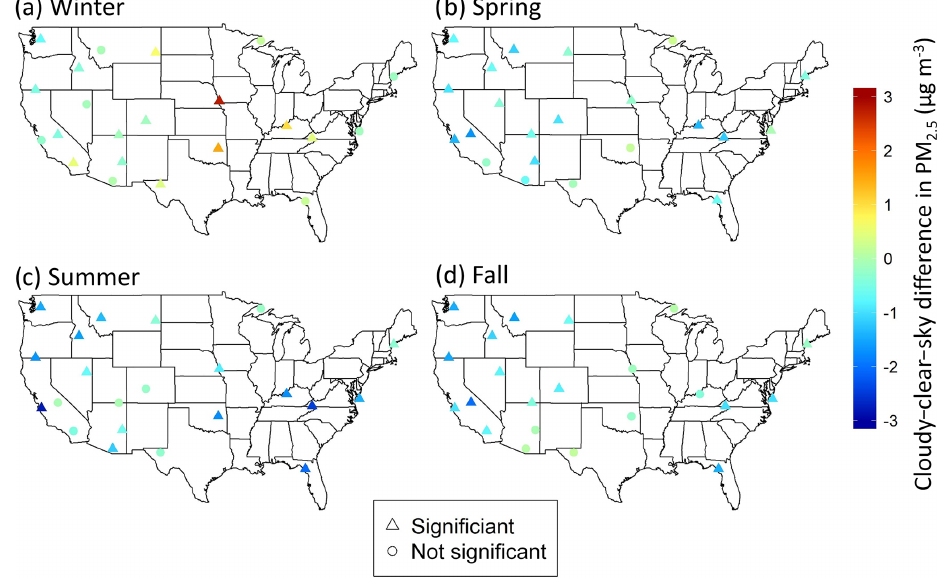
Figure A1. Maps of the difference in PM 2 . 5 mass concentration medians (cloudy–clear-sky) for all regions from 2010 to 2014 for (a) winter, (b) spring, (c) summer, and (d) fall. The color of the point corresponds to the magnitude of the difference. Triangles indicate that median differences are significant according to the Mann–Whitney U test.